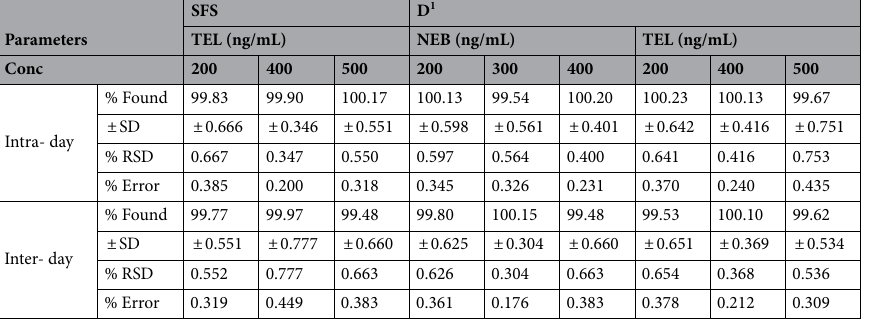
Table 3. Precision data for NEB and TEL estimation using the studied synchronous and first derivative synchronous spectrofluorimetric techniques. N. B. Each result is the average of three separate determinations.